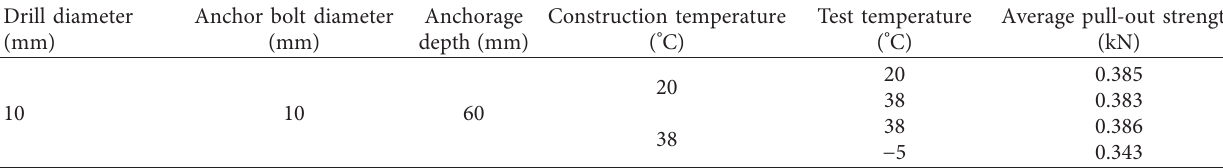
Table 3: Pull-out test strength data of different temperatures.